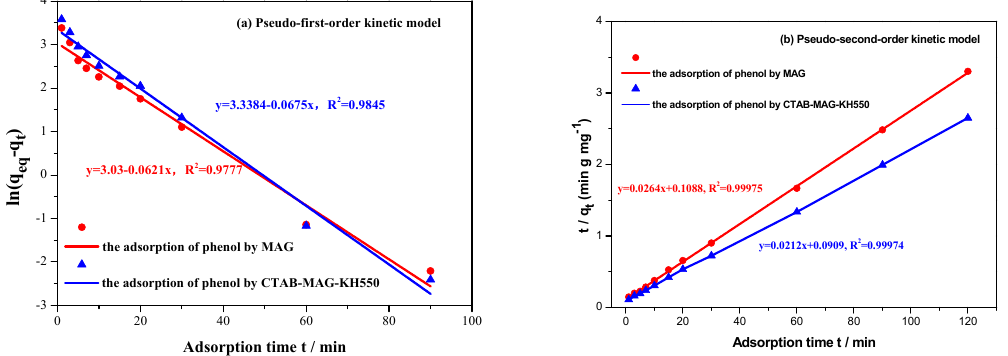
Figure 6. Kinetic curves of the sorption of phenol for pristine MAG and MAG–CTAB–KH550 in the conditions of initial phenol concentration at 50 mg/L, the pH value at 10, and sorbents dosage at 1 g/L for: ( a ) Pseudo-first-order kinetic model; ( b ) Pseudo-second-order kinetic model.